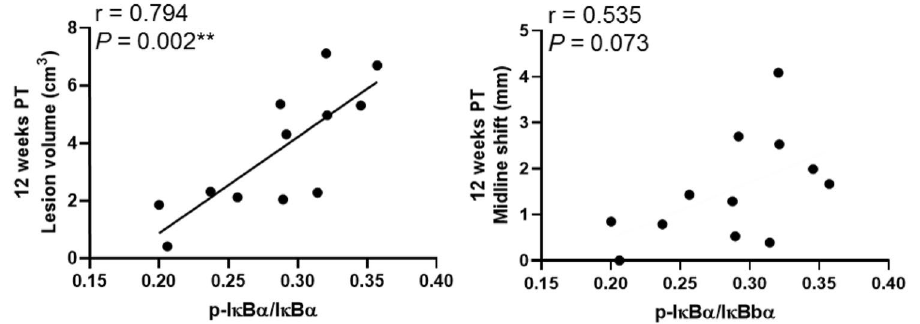
Figure 4. Protein levels of phosphorylated IkBα correlated with the brain lesion volume and midline shift changes 12 weeks post-treatment. Lesion volume and midline shift at 12 weeks PT were positively correlated with jejunal protein levels of phosphorylated IkBα at 12 weeks PT. r = Pearson correlation coefficient and P values are shown. * P < 0.05, ** P < 0.01.